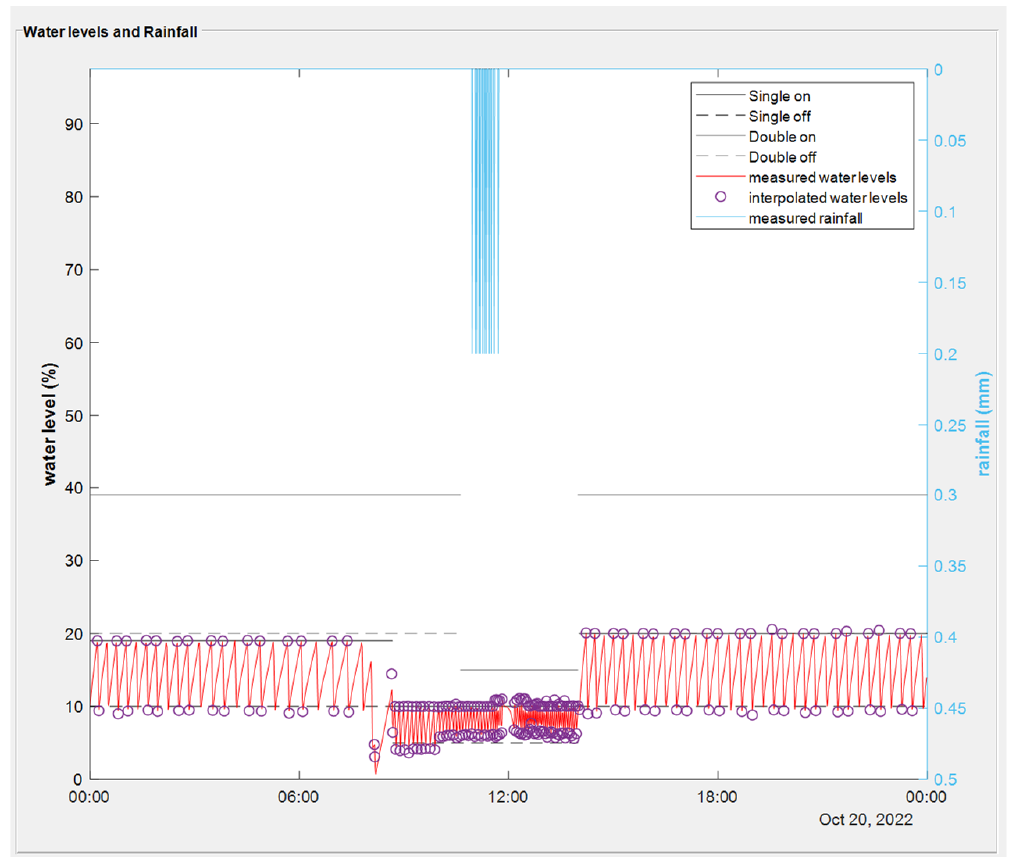
Figure A5. Effect of variation of switch levels.